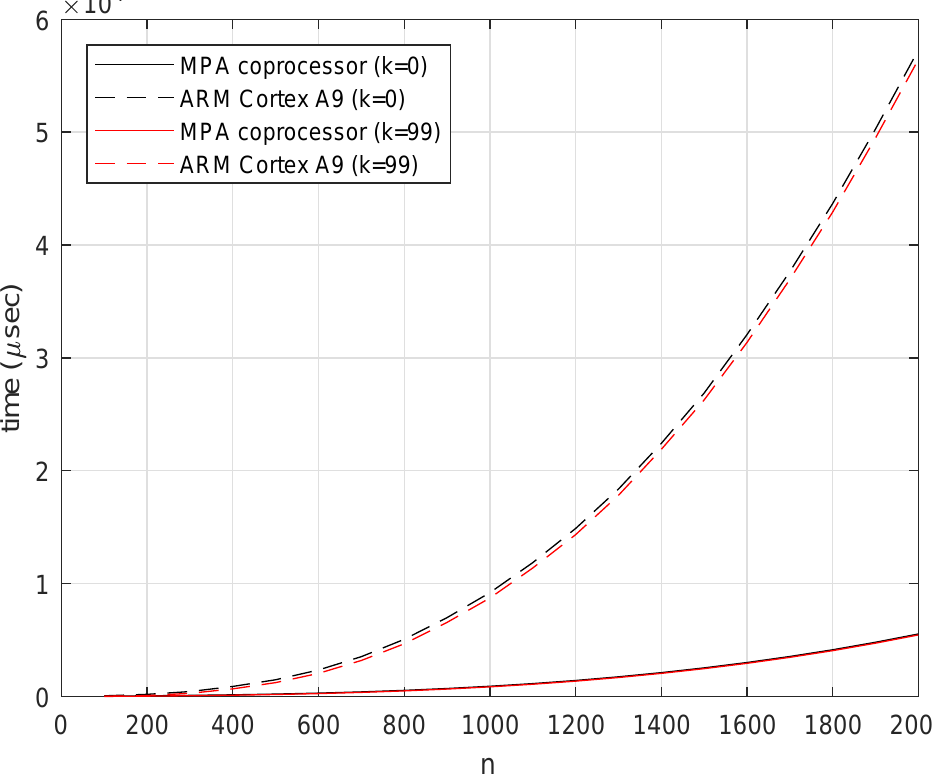
Figure 11. Runtimes for DGF computations. MPA coprocessor results overlap for k = 0 and k =